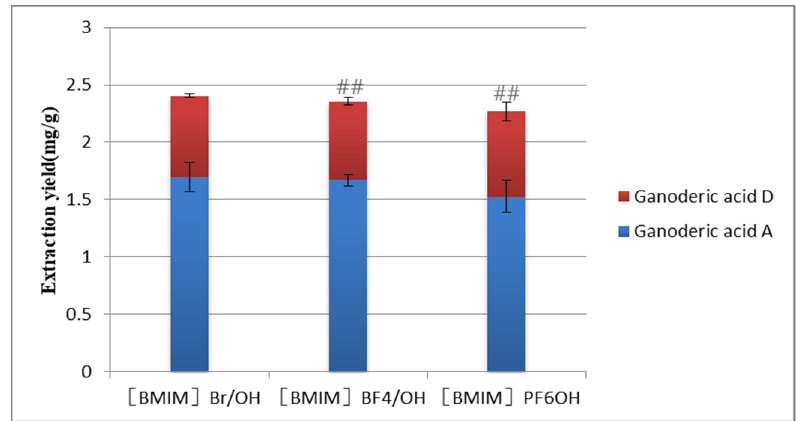
Figure 2. Influence of different types of anions on the extraction yield. Compared with [HMIM] Br/methanol group: ## p < 0.01.